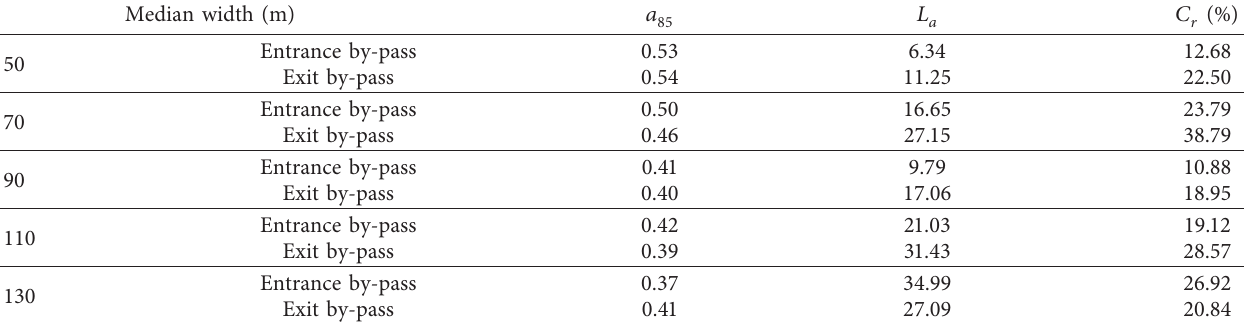
Figure 7: Deceleration cumulative frequency in (a) entrance by-pass and (b) exit by-pass. Table 5: Cumulative driving risk in each driving configuration.